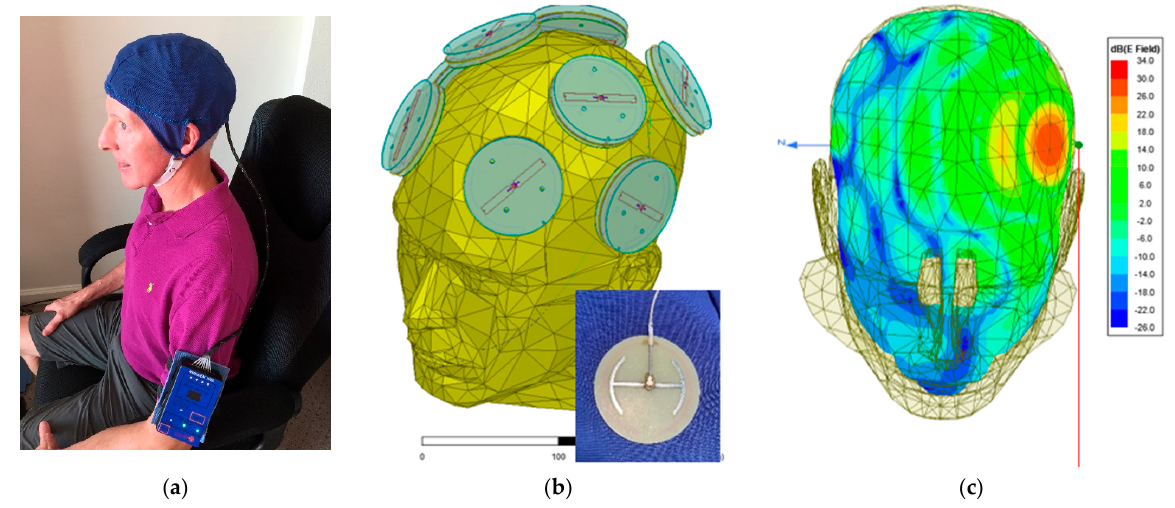
Figure 1. ( a ) A MemorEM TM device being worn by a 63-year-old individual. The control